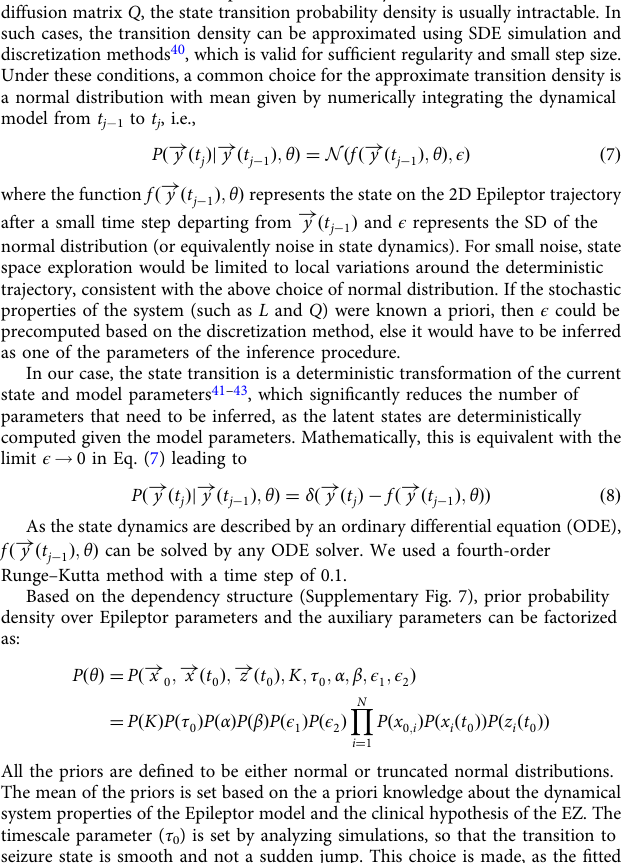
Table 1 Mean and SD of the normal prior probability densities.